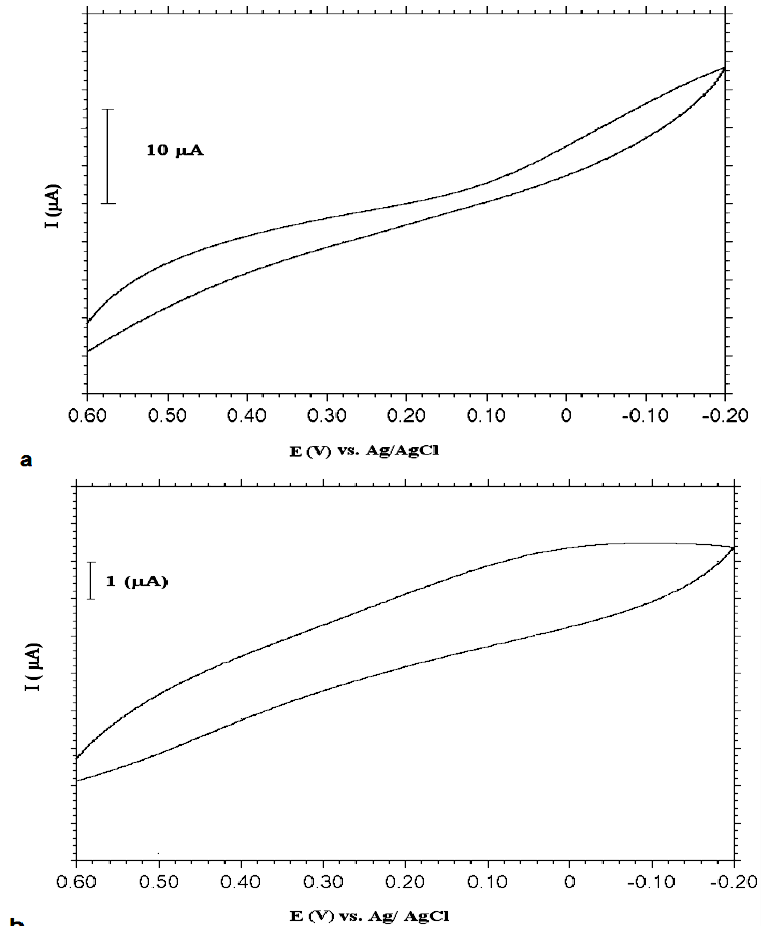
Figure 8. CVs of PANI ( a ) (deposited by CV method: 10 cycles) ( b ) (deposited by bulk electrolysis: at 0.9 V for 20 minutes) coated MUA modified Au electrode in 0.1 M Fe(CN) 63−/4− solution.